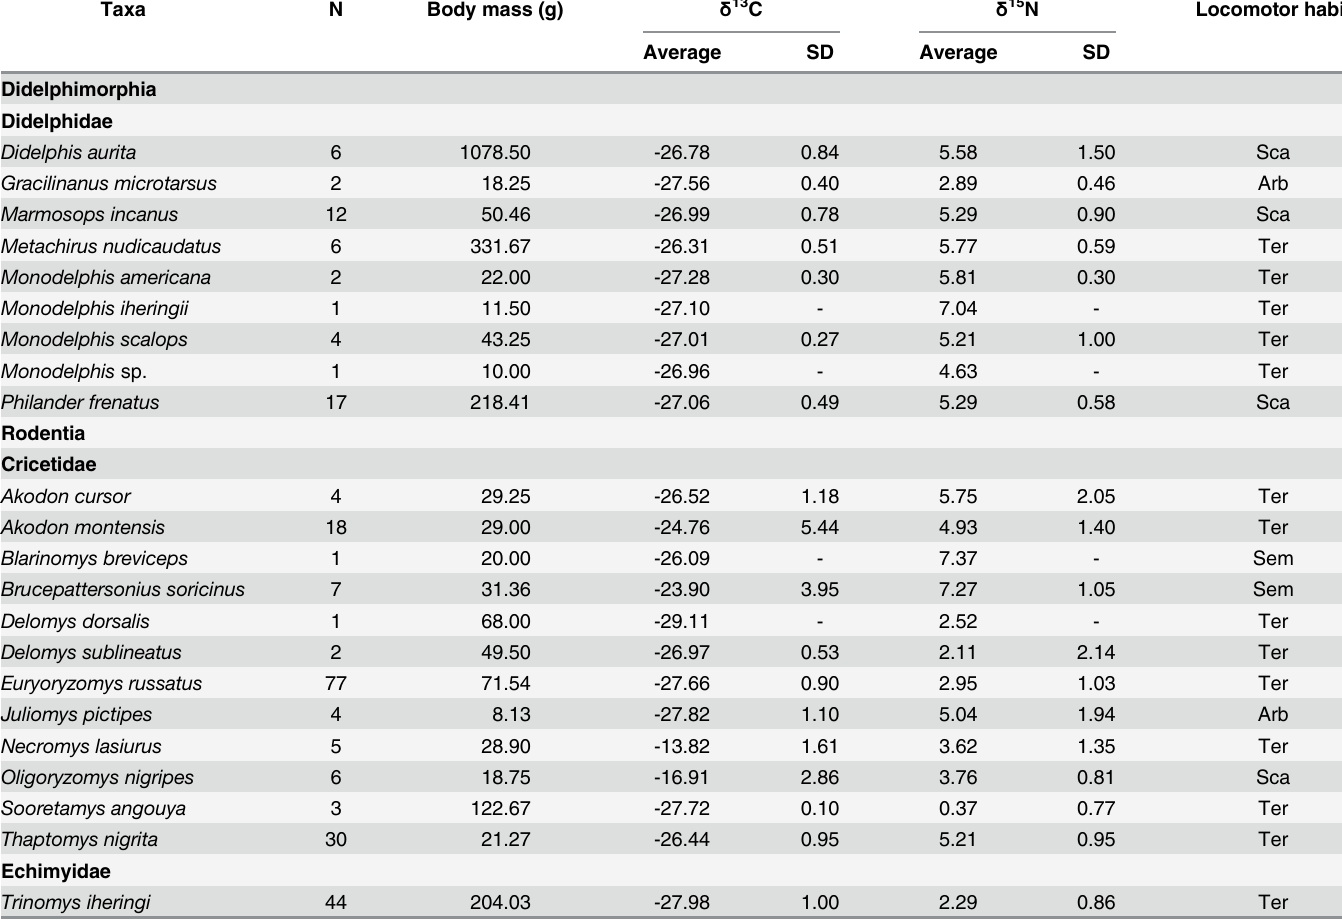
Table 1. Number of captured individuals, mean body mass (g), δ 13 C ( ‰ PDB) and δ 15 N ( ‰ Air) values and locomotor habit (Sca = scansorial, Arb = arboreal, Ter = terrestrial and Sem = semifossorial) of the 22 small mammal species (nine marsupials and 13 rodents) in the Atlantic forest areas.